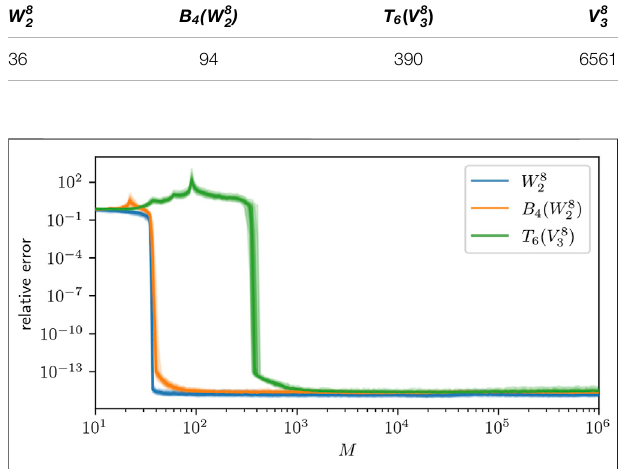
FIGURE 1 | 0.15 – 0.85 quantiles for the recovery error in W 8 2 (blue), B 4 ( W 8 2 ) (orange), and T 6 ( V 8 3 ) (green). The relative error is computed with respect to the L 2 -norm using a Monte Carlo estimation with 10 6